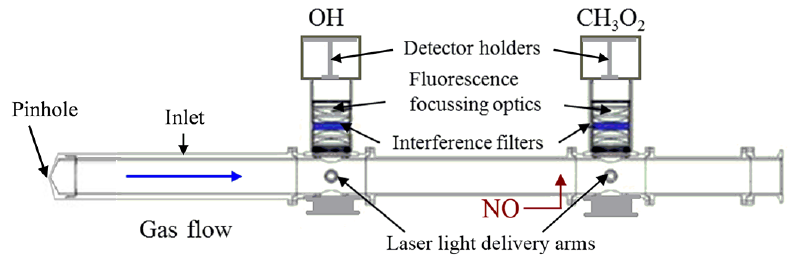
Figure 1. Vertical cross section of the FAGE fluorescence cells. The first (left) fluorescence cell was used to detect OH fluorescence through a 308 . 8 ± 5 . 0nm bandpass filter (transmission >50%) and the second cell to detect CH 3 O 2 after titration with added NO to form CH 3 O using a bandpass filter between 320 and 430nm with an average transmission